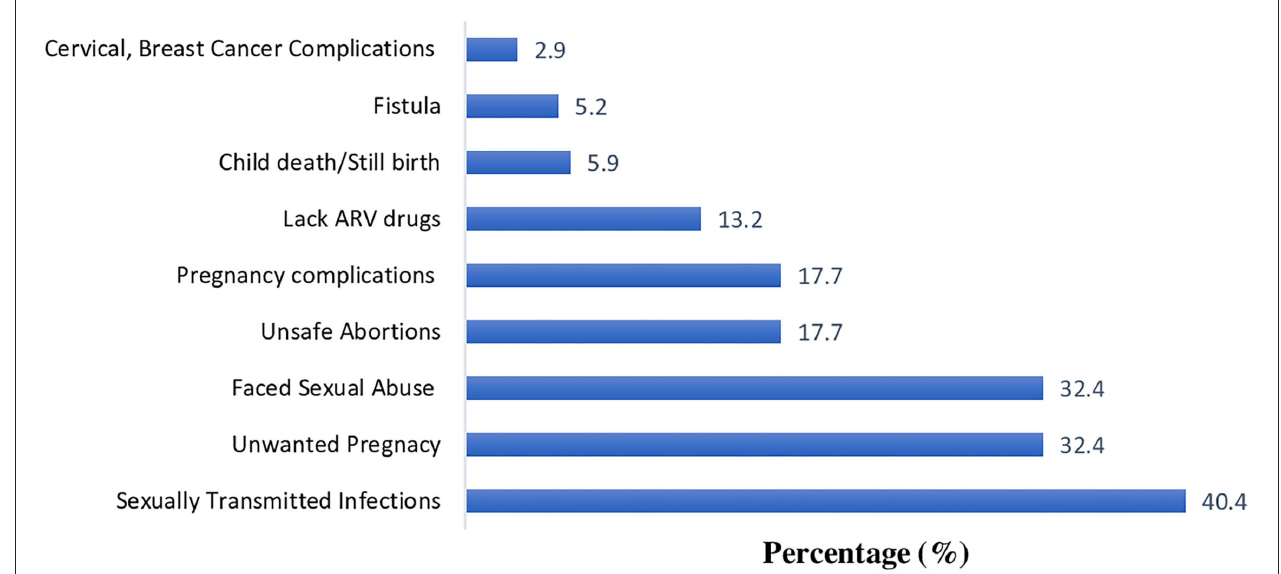
FIGURE 3 | Problems associated with limited access to SRH information and services among Ugandan youth during the COVID-19 lockdown.